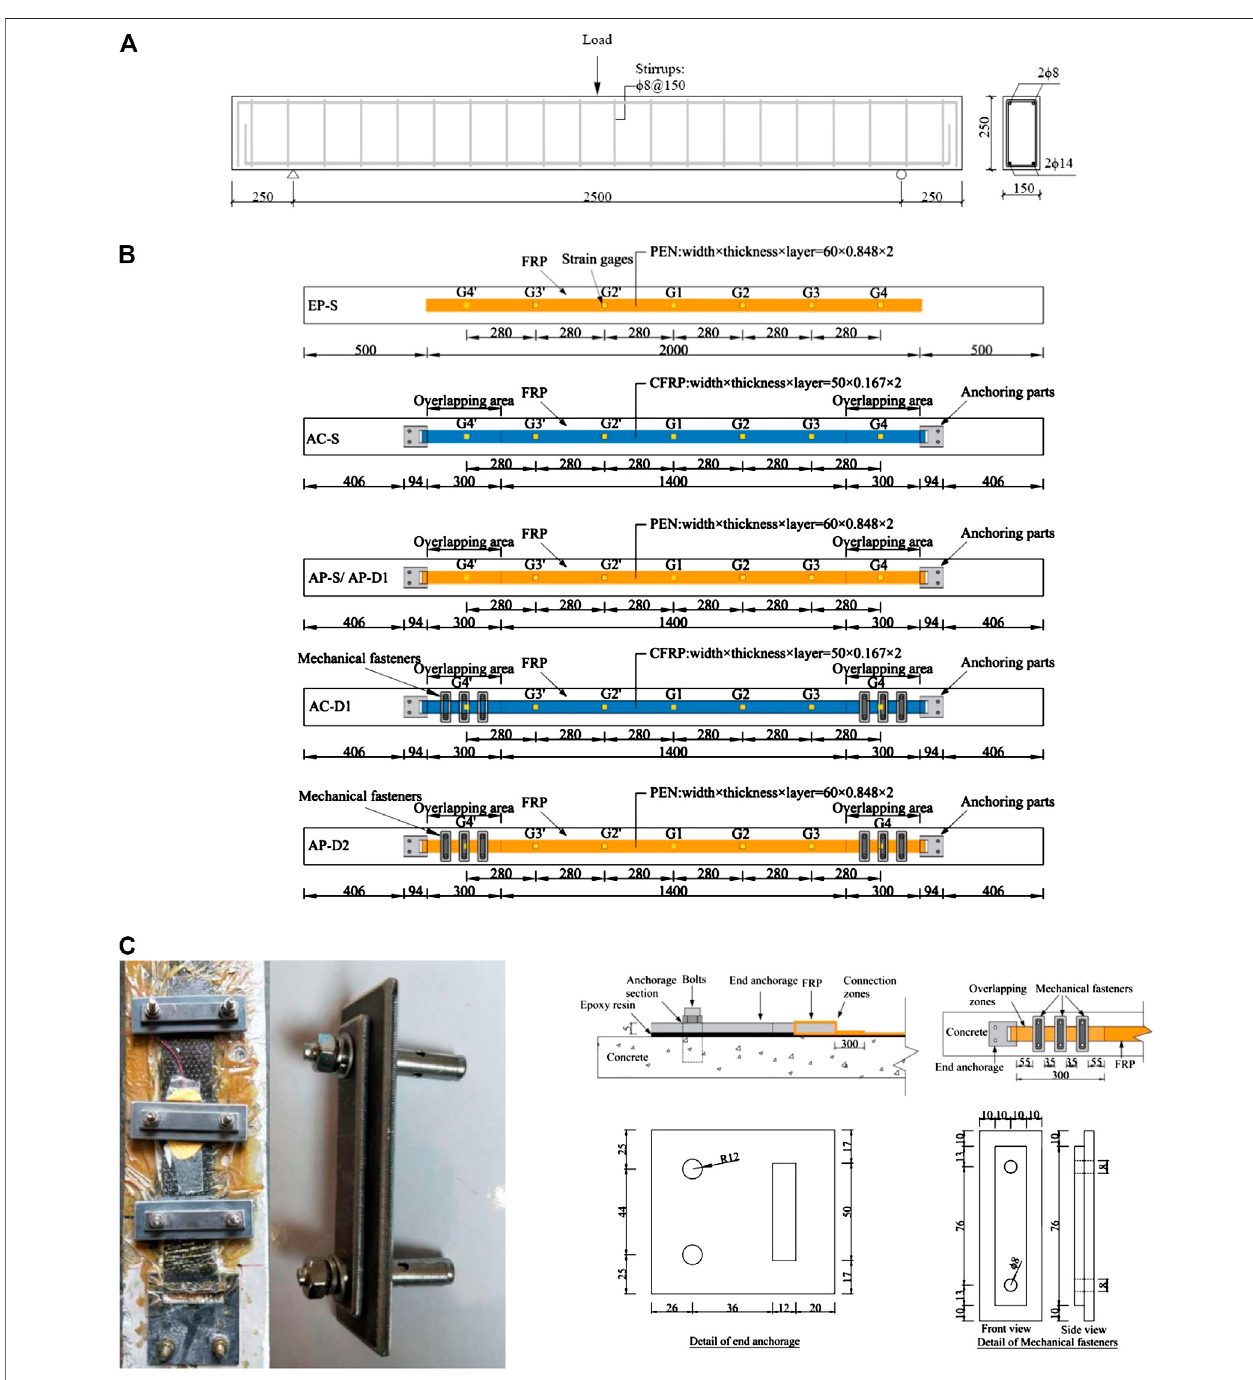
FIGURE1| Detailsoftestedspecimens. (A) Con fi gurationandreinforcementdetails. (B) FRPstrengthening system. (C) Detailsofend-anchorageandmechanical fasteners.